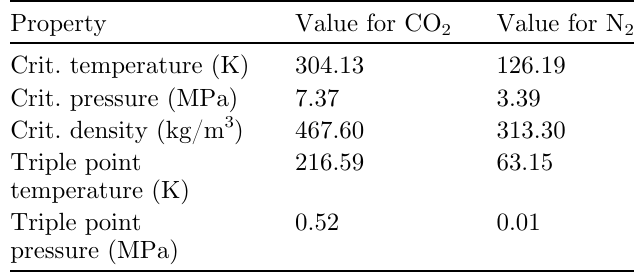
Table 1. Comparison of physical properties of CO